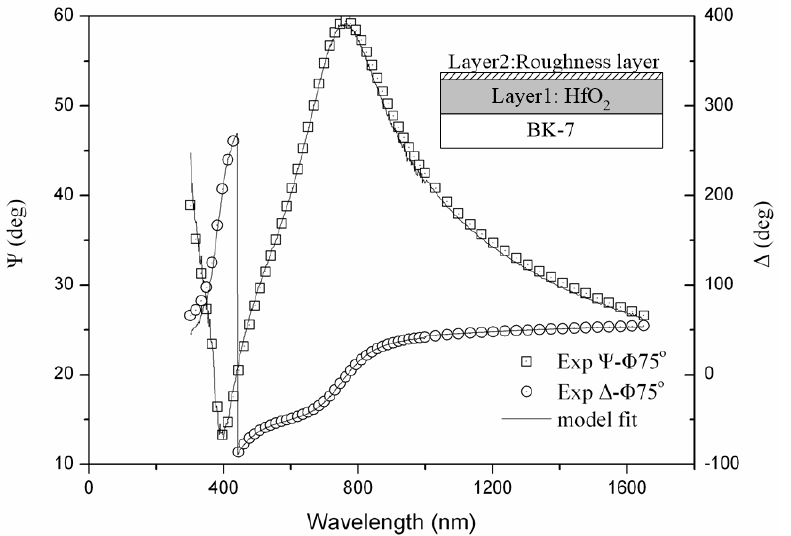
Figure 1. Typical HfO 2 thin film measured data and fitting curves with fits to the Cauchy formula. The optical model is shown in the inserts at the top right corner.